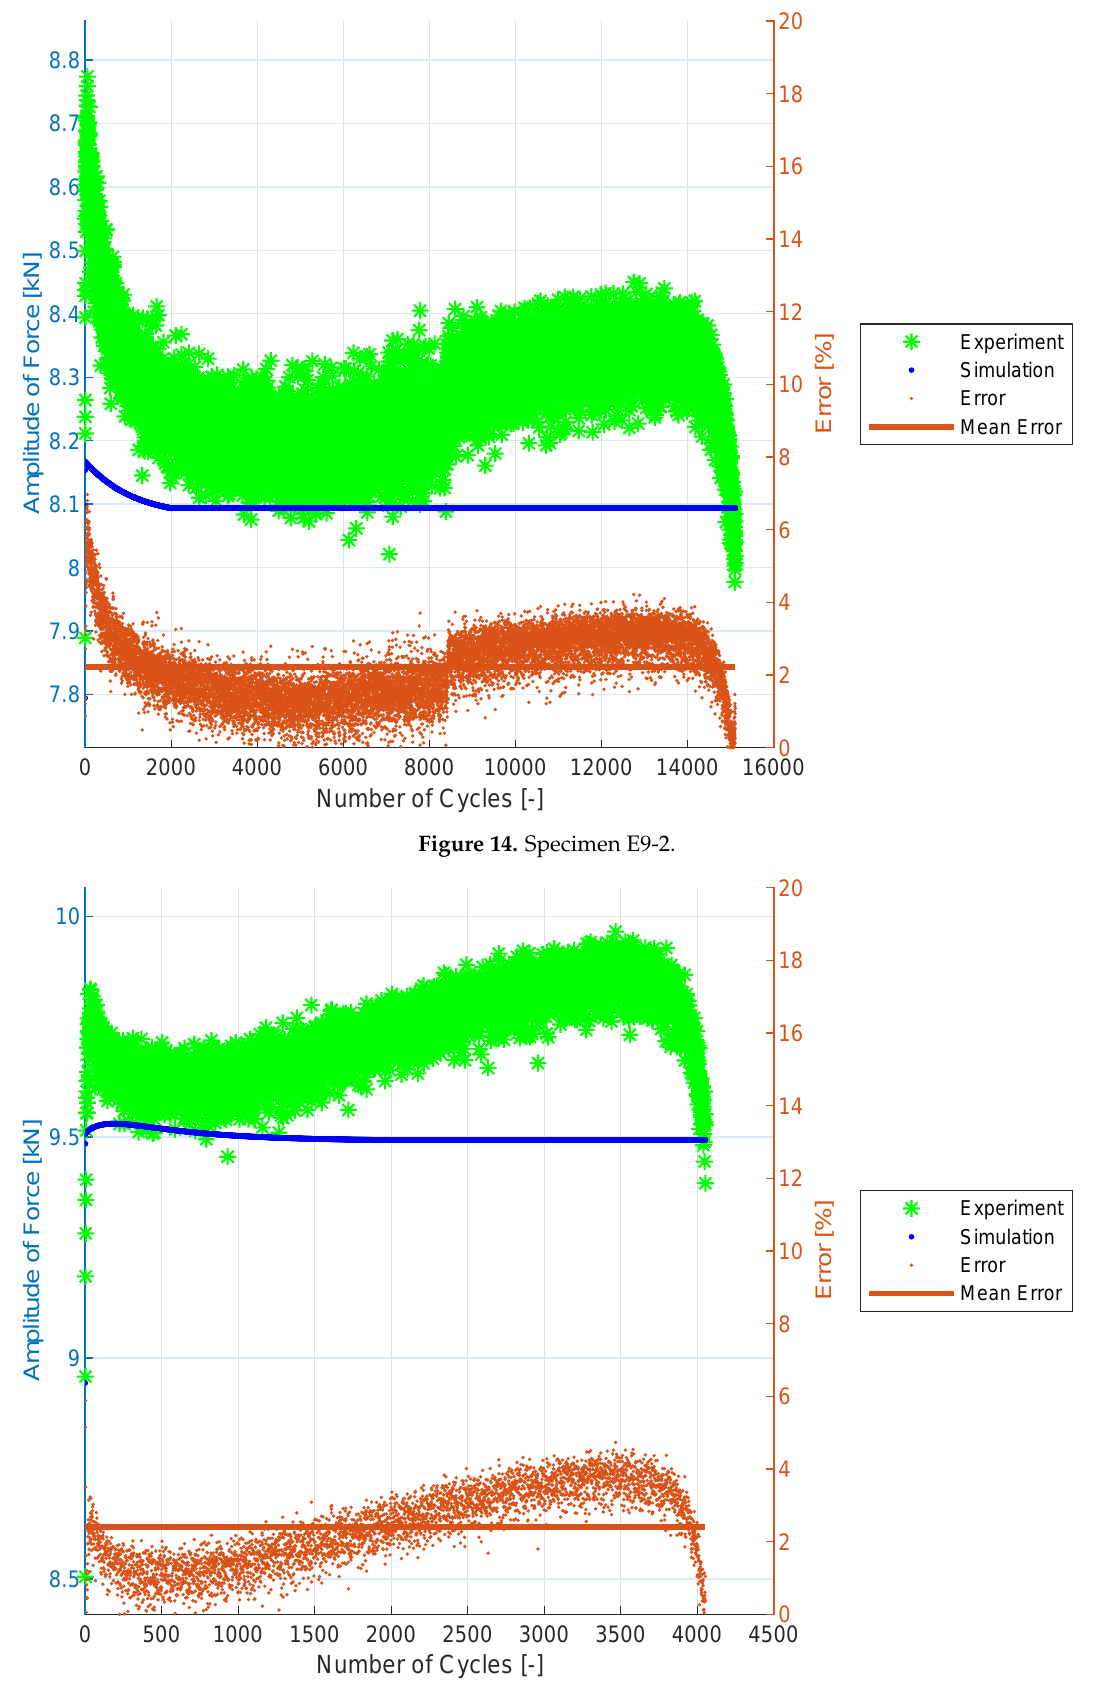
Figure 15. Specimen